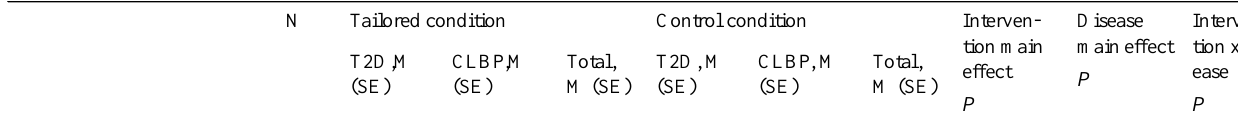
Table 5. Results of ITT and AC